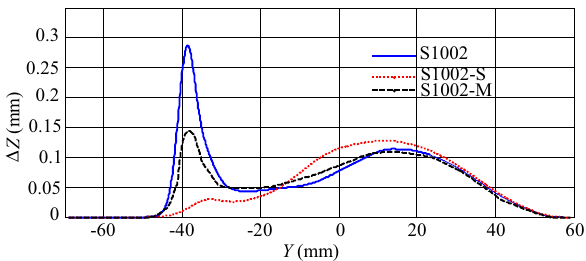
Fig. 16 Comparison of wear distribution of the S1002, S1002-S, and S1002-M profiles